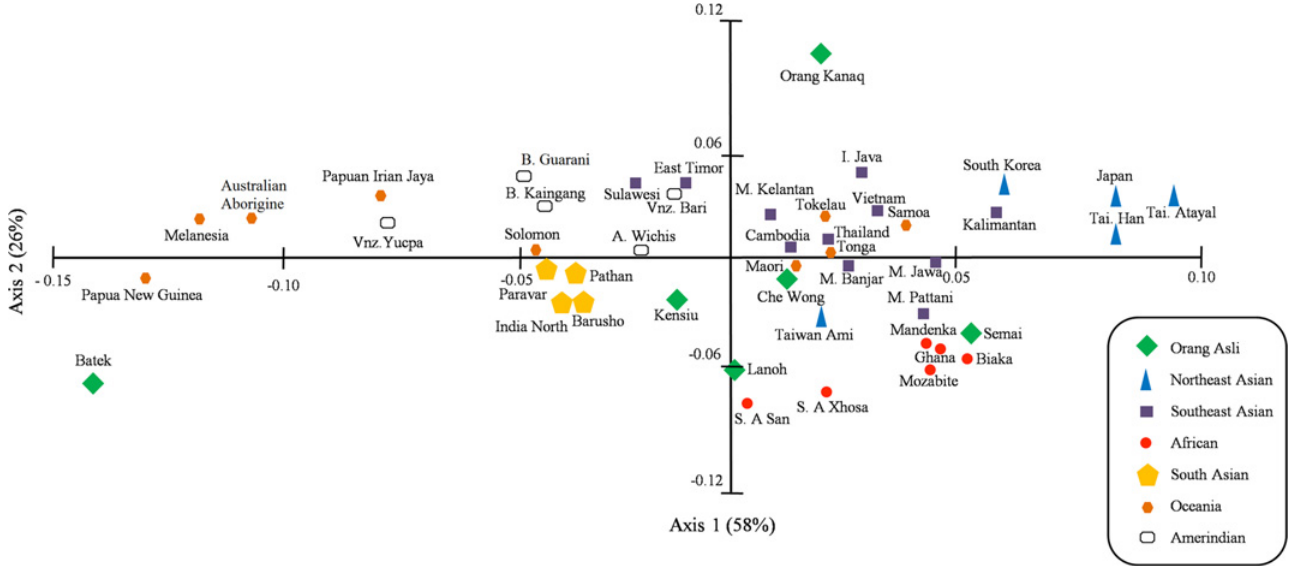
Fig 3. Principal component analysis plot shows the distribution of global populations based on KIR genes. All estimated KIR genes frequencies ( gF ) of the populations used are listed in S5 Table. A = Argentina; B = Brazil; I = Indonesia; M = Malay; S. A = South Africa; Tai = Taiwan; Vnz =